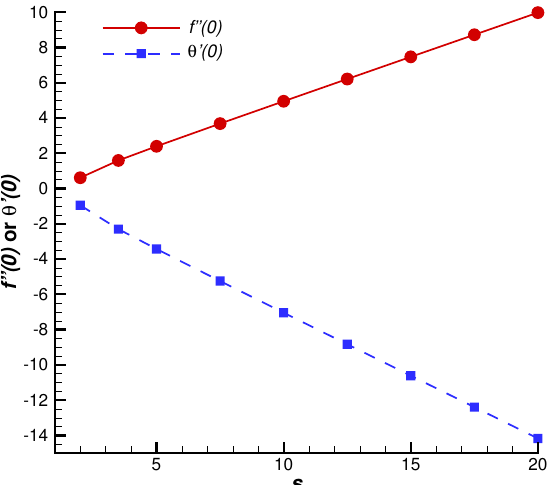
Figure 2. Comparison of convergent series solutions of f (cid:48)(cid:48) ( 0 ) and θ (cid:48) ( 0 ) obtained by HAM with the numerical results for different values of suction parameter s when γ = M = 1, Pr = 0.71. Solid line: convergent series solutions of f (cid:48)(cid:48) ( 0 ) ; dashed line: convergent series solutions of θ (cid:48) ( 0 ) ; circles: corresponding numerical